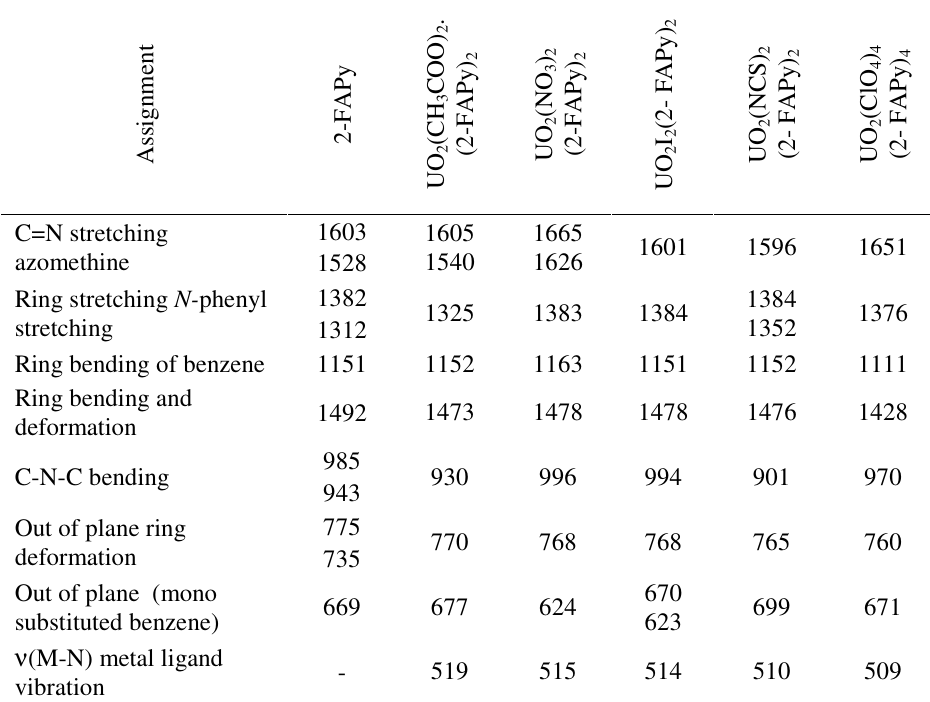
Table 3. Infra red absorption frequencies (cm -1 ) for dioxouranium(VI) complexes of